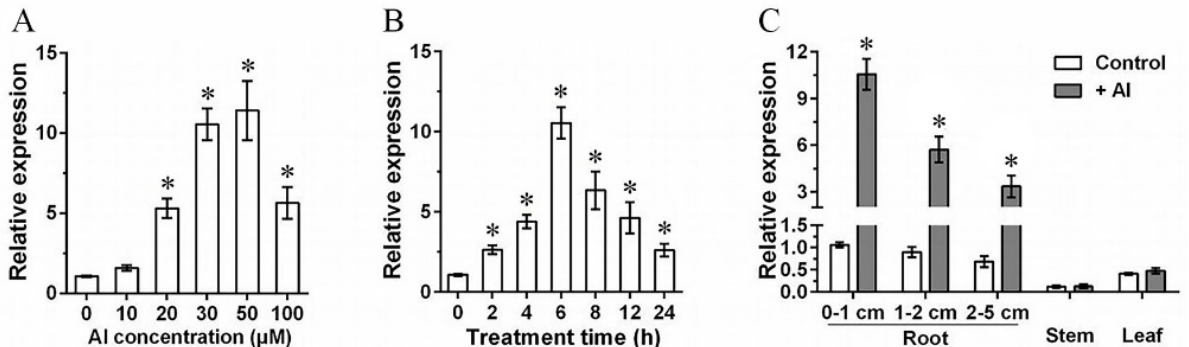
Figure 1. Analysis of GmWRKY81 gene expression patterns. ( A ) Relative expression of GmWRKY81 after treatment with 0, 10, 20, 30, 50 and 100 μ M AlCl 3 for 6 h. ( B ) Relative expression of GmWRKY81 with 50 μ M AlCl 3 treatment for 0, 2, 4, 6, 8, 12 and 24 h. ( C ) Relative expression of GmWRKY81 in different tissues of plants (roots, stems and leaves) with or without 50 μ M AlCl 3 treatment for 6 h. Asterisks denote significant differences: p < 0.05. The data are presented as the means ± SD from three biological replicates.